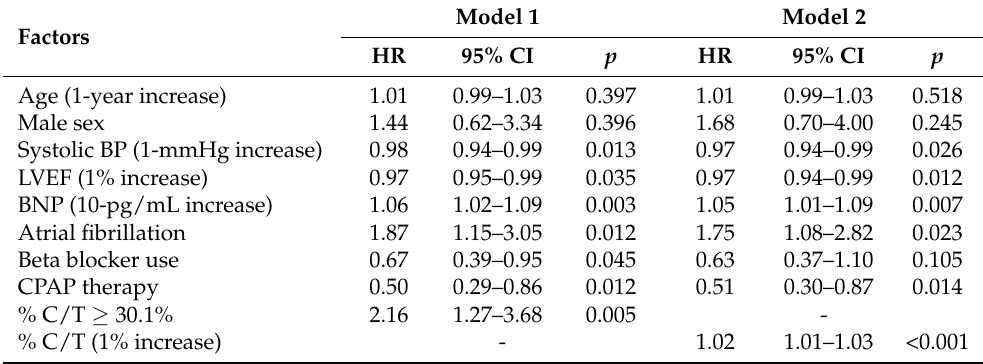
Table 4. Results of multivariate analysis assessing prognostic factors for clinical